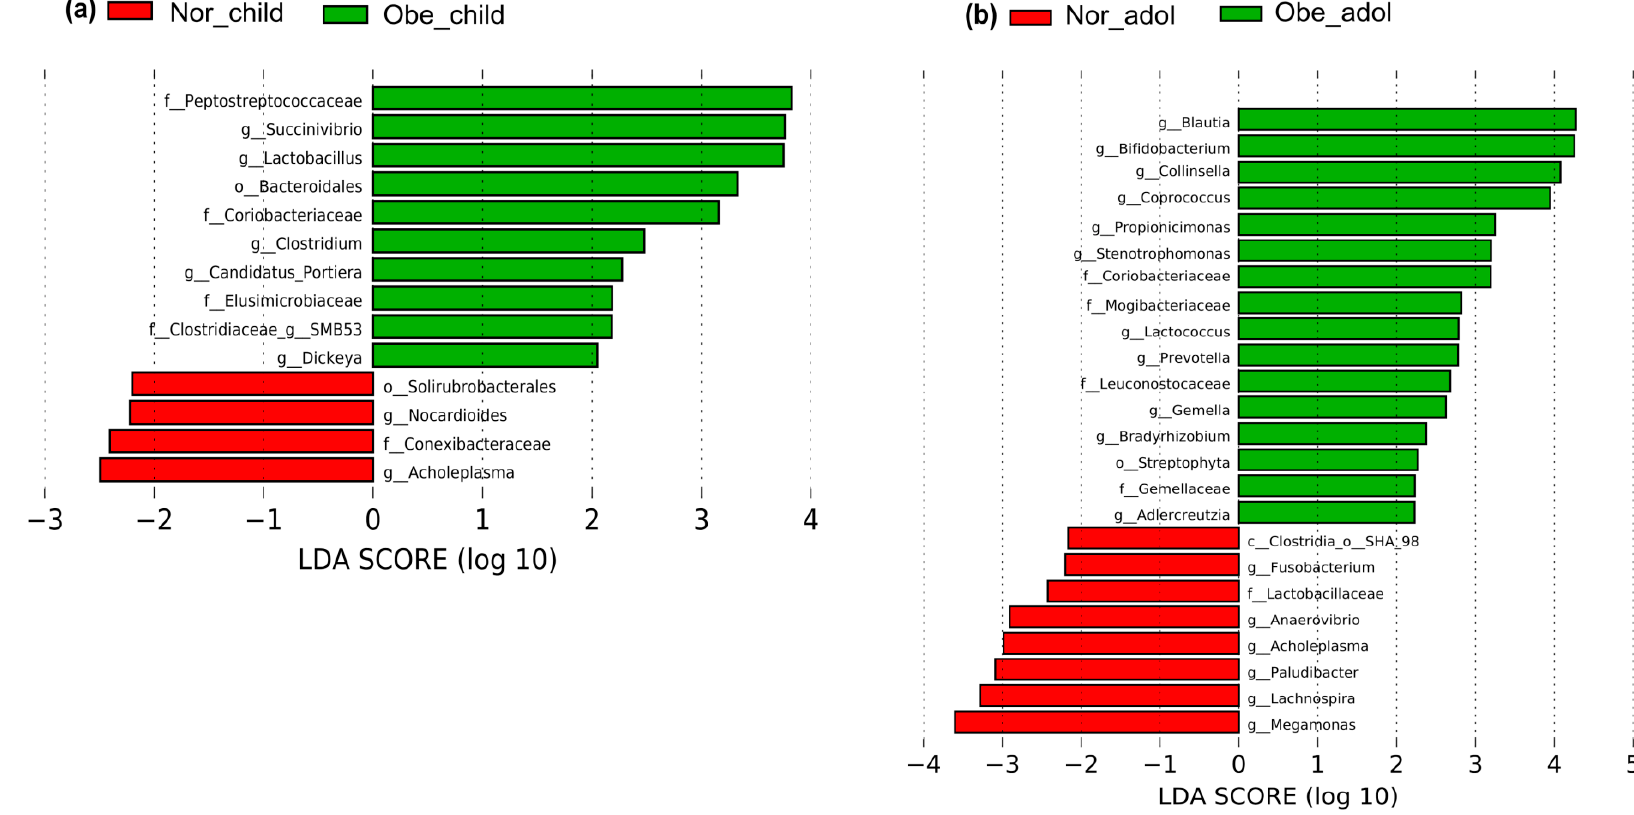
Figure 3. Graphics of Linear discriminant analysis (LDA) effect size (LEfSe) for children ( a ) and adolescents ( b ). Horizontal bars represent the effect size for each taxon. The length of the bar represents the log 10 transformed LDA score, indicated by vertical dotted lines. Normal weight children and adolescents are indicated by red, and obesity by green. The threshold on the logarithmic LDA score for discriminative features was set to 2.0. The taxon of bacteria with statistically significant change ( p < 0.05) in the relative abundance is written alongside the horizontal lines. The name of the taxon level is abbreviated as p—phylum; c—class; o—order; f—family, and g—genus. Tags above the graphics are normal weight children, obese children, normal weight adolescents, and obese adolescents. Data were processed as described in Materials and Methods section. Statistically significant values are in additional data Table S4 and S5.